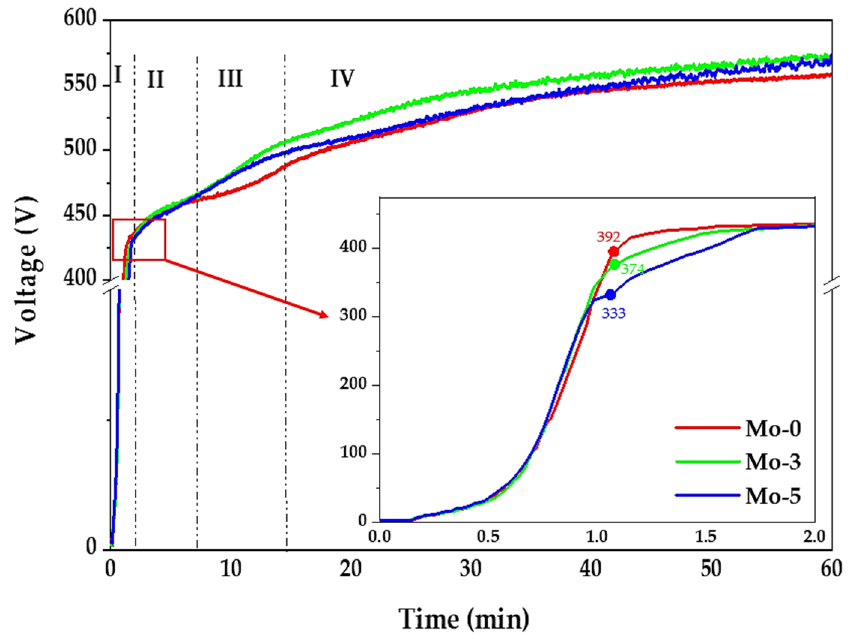
Figure 1. Voltage vs. time responses during PEO treatments in baths containing various amounts of Na 2 MoO 4 .